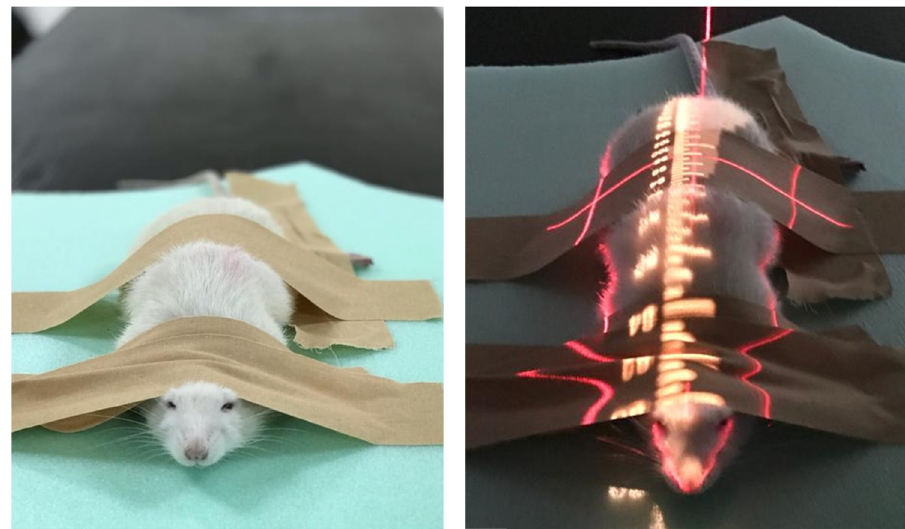
Figure 1: Positioning of rat on the treatment couch.